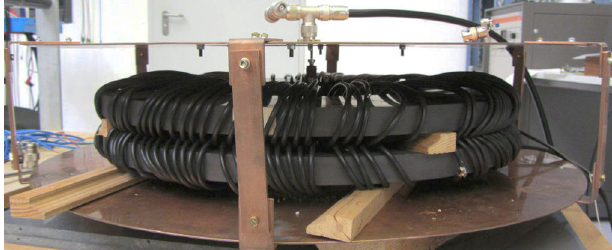
FIG. 1. Experimental setup in the reflection measurement mode. The ferrite ring pair with bias windings is located inside the cavity 249 mm; its housing. The outer radius of each ring core is r out ¼ 50 mm. Further dimensions of the setup are given height is h core ¼ in Table II and Fig. 3.Note that the housing is not fully closed at the outer surface. The N-type cable in the center on top is connected to the VNA. A 50 Ω resistor can be installed in parallel.